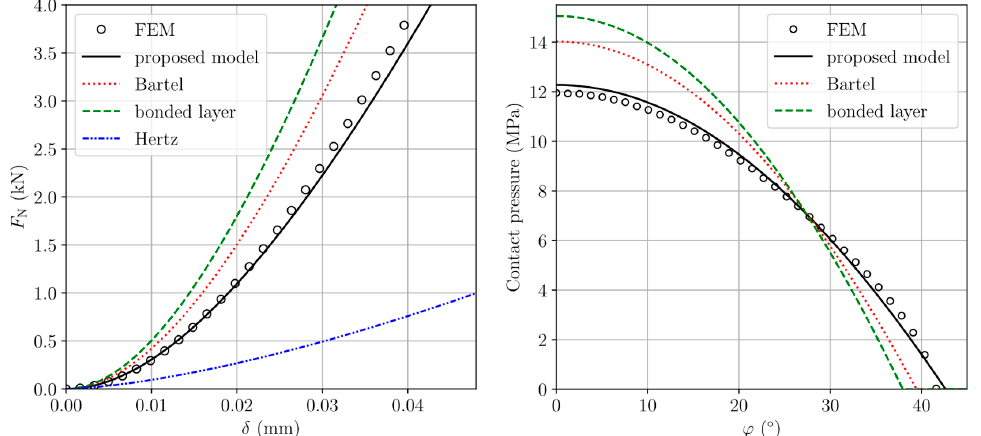
Figure 4. Comparison of the FEM solutions with Hertzian theory, Bartel’s analysis, results from the bonded-layer-model, and the new proposed model, respectively, for a Poisson’s ratio of 0.45, inner cup radius 18 mm, clearance 0.1 mm, and liner thickness 6.75 mm: normal force as a function of indentation depth ( left ), and pressure distribution as a function of angular coordinate for a normal force of 3000 N ( right ).